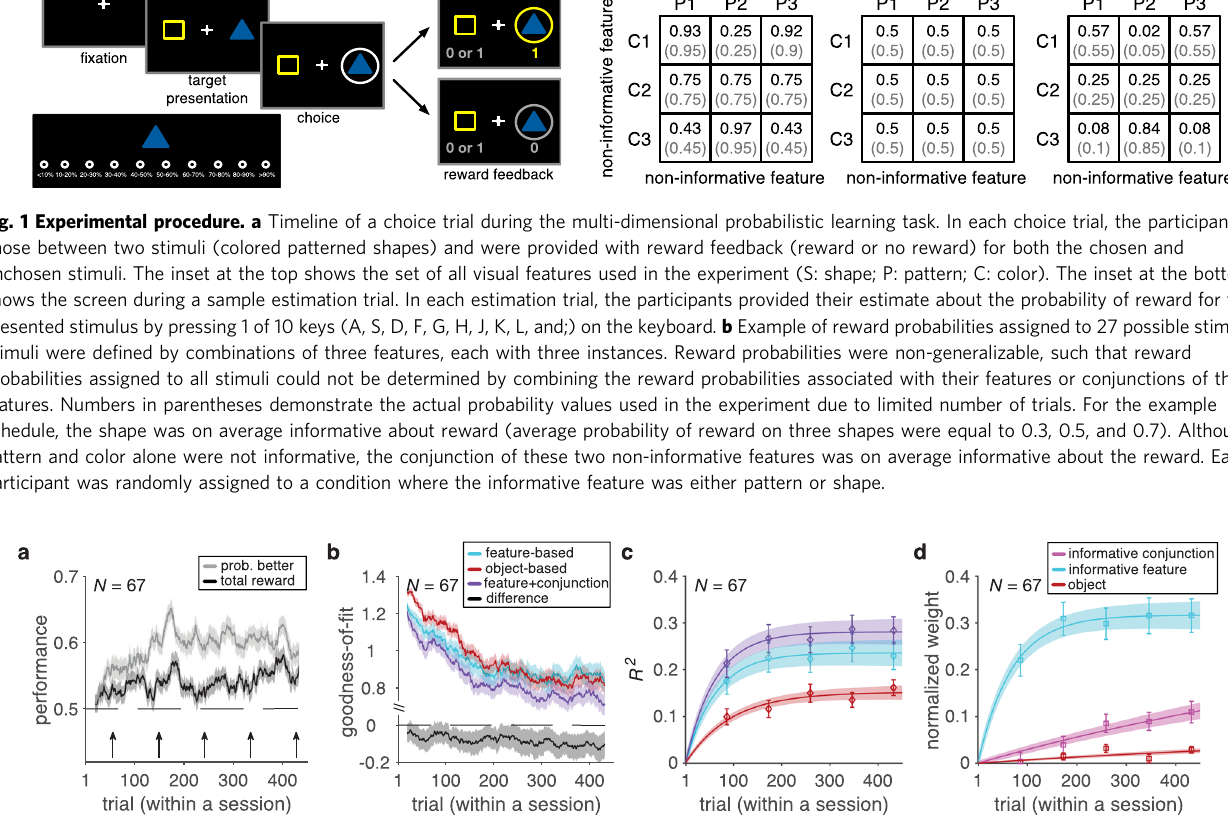
Fig. 2 Evidence for adoption of mixed feature- and conjunction-based learning. a Time course of performance and learning during the experiment. Plotted are the average total harvested reward and probability of selecting the better stimulus (i.e., stimulus with higher probability of reward) in a given trial within a session of the experiment. The running average over time is computed using a moving box with the length of 20 trials. The shaded areas indicate ±s.e.m., and the dashed line shows chance performance. b Plotted is the goodness-of- fi t based on the average AIC per trial, AIC p , for the feature-based model, object-based model, and the best mixed feature- and conjunction-based (F + C 1 ) model. The smaller value corresponds to a better fi t. The black curve shows the difference between the goodness-of- fi t for the F + C 1 and feature-based models. c The plot shows the time course of explained variance ( R 2 ) in participants ’ estimates based on different GLMs. Color conventions are the same as in panel b with cyan, red, and purple curves representing R 2 based on the feature-based, object-based, and F + C 1 models, respectively. The solid line is the average of fi tted exponential function to each participant ’ s data and the shaded areas indicate ±s.e.m. of the fi t. d Time course of adopted learning strategies measured by fi tting participants ’ estimates of reward probabilities using a stepwise GLM. Plotted is the normalized weight of the informative feature, informative conjunction, and object (stimulus identity) on reward probability estimates. Error bars indicate s.e.m. The solid line is the average of fi tted exponential function to each participant ’ s data, and the shaded areas indicate ±s.e.m. of the fi t. Source data are provided as a Source Data